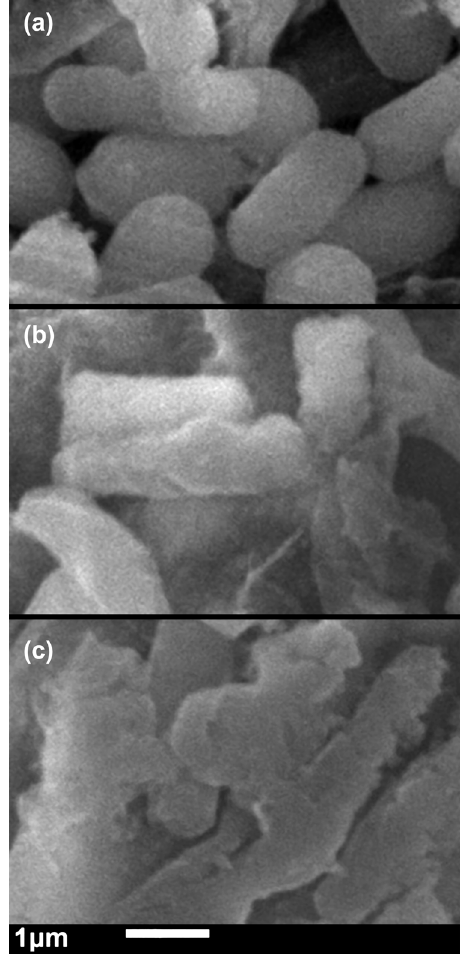
Figure 4: SEM imaging of NC/NSe composites ’ action on Aeromonas hydrophila cells after exposure for 4 h ( b ) and 8 h ( c ) , comparing to control ( a )